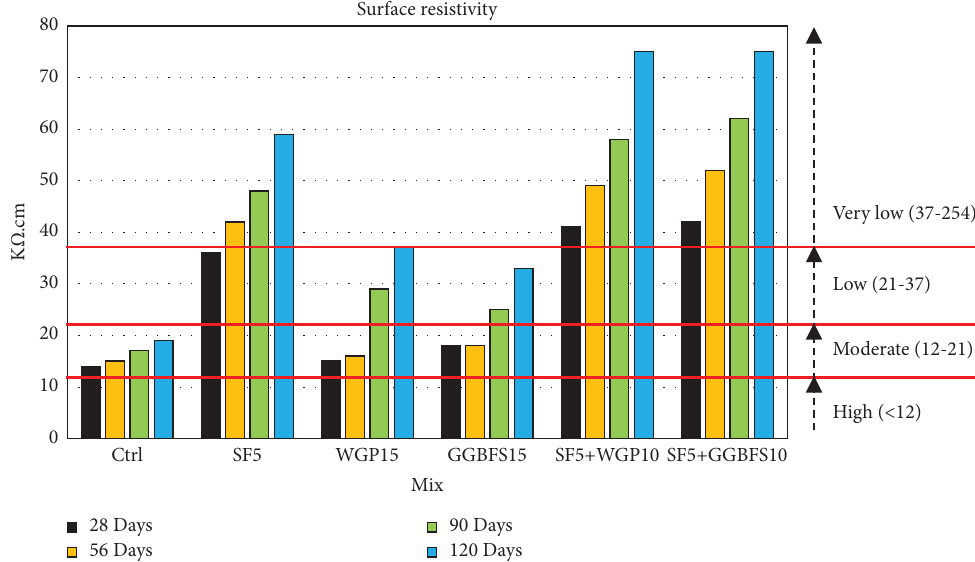
Figure 10: Surface resistivity results of concrete mixtures. Table 3: Chloride ion penetration based on AASHTO-T 358. Chloride ion